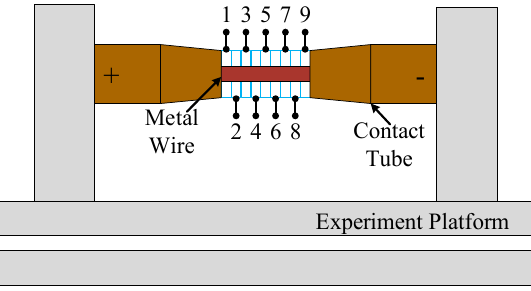
Figure 5. Schematic diagram of metal wire temperature distribution at different positions.